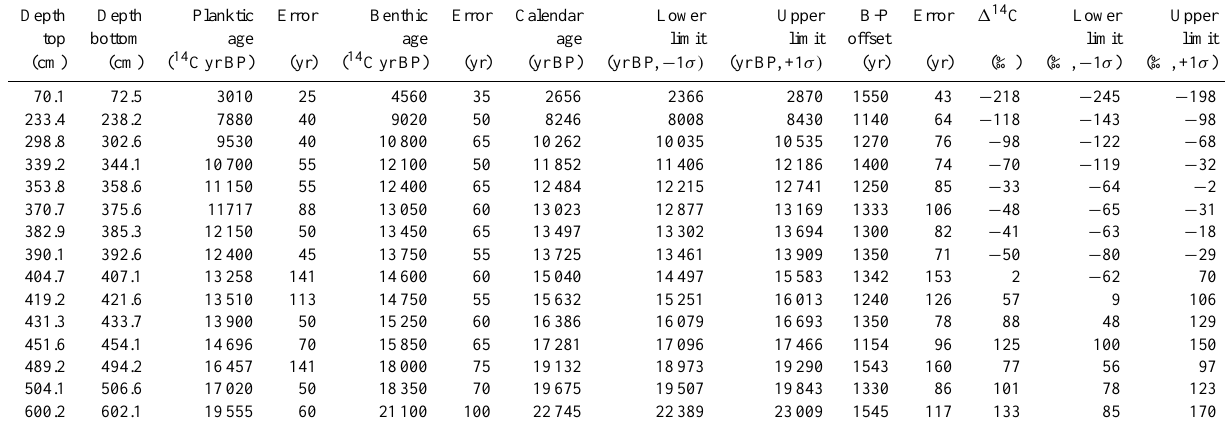
Table 4. Radiocarbon measurements on paired planktic and benthic foraminifera, reconstructed ventilation ages and bottom-water 1 14 C values in core MD01-2420. Errors are ± 1 σ